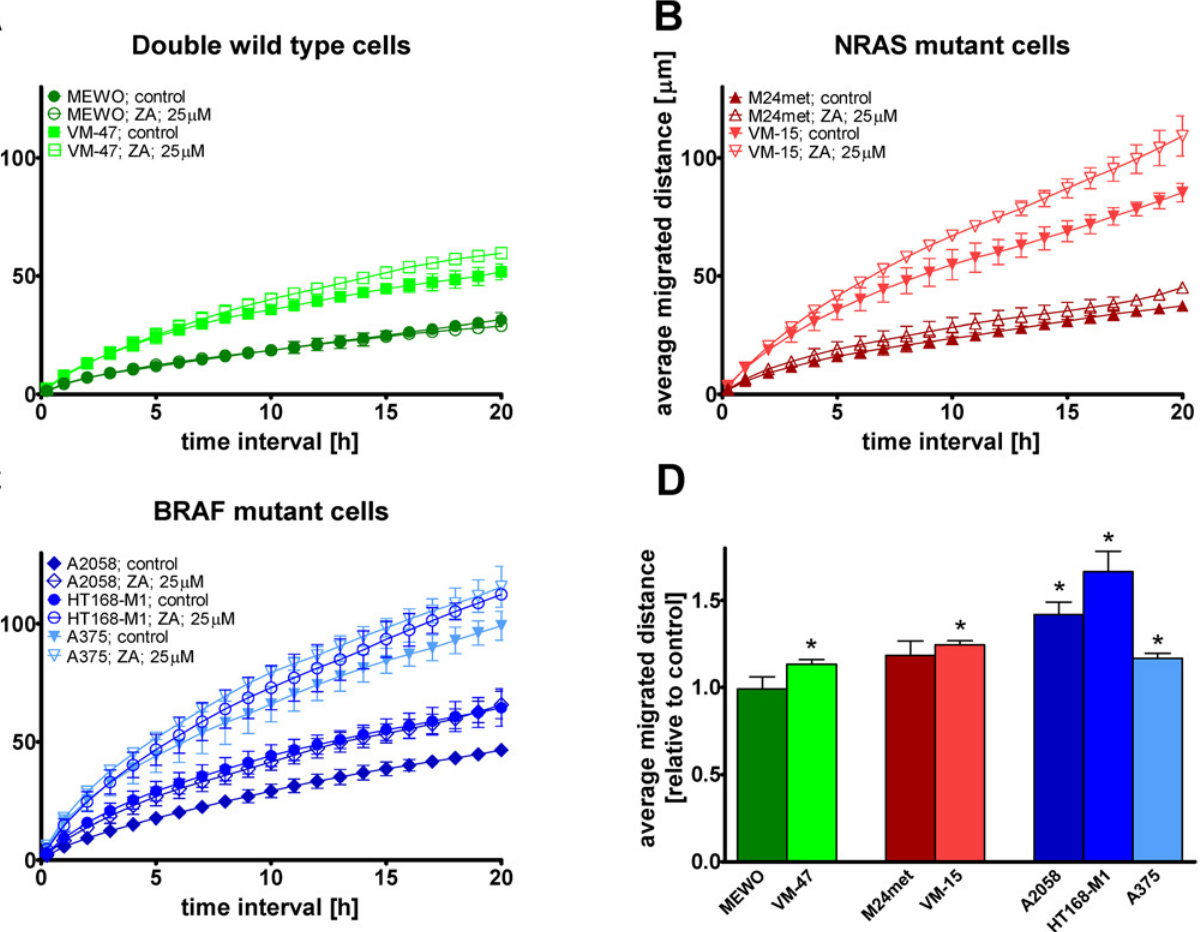
Fig 2. Cell migration after zoledronic acid treatment in melanoma cells. ( A-C ) Migrated distance as a function of time and ( D ) average migrated distance after zoledronic acid (ZA) treatment in melanoma cells measured by videomicroscopy. A profound and significant increase in migrated distance was found in all of the BRAF mutant cells. A modest but significant increase in migration was found in VM-47 triple wild-type and VM-15 NRAS mutant cells. Colors blue, red and green indicate BRAF, NRAS mutation and wild-type for these genes, respectively. Data shown as average ± SEM are from at least three independent measurements. Asterisks indicate significant difference of p < 0.05 from the respective control with unpaired two-tailed T test.